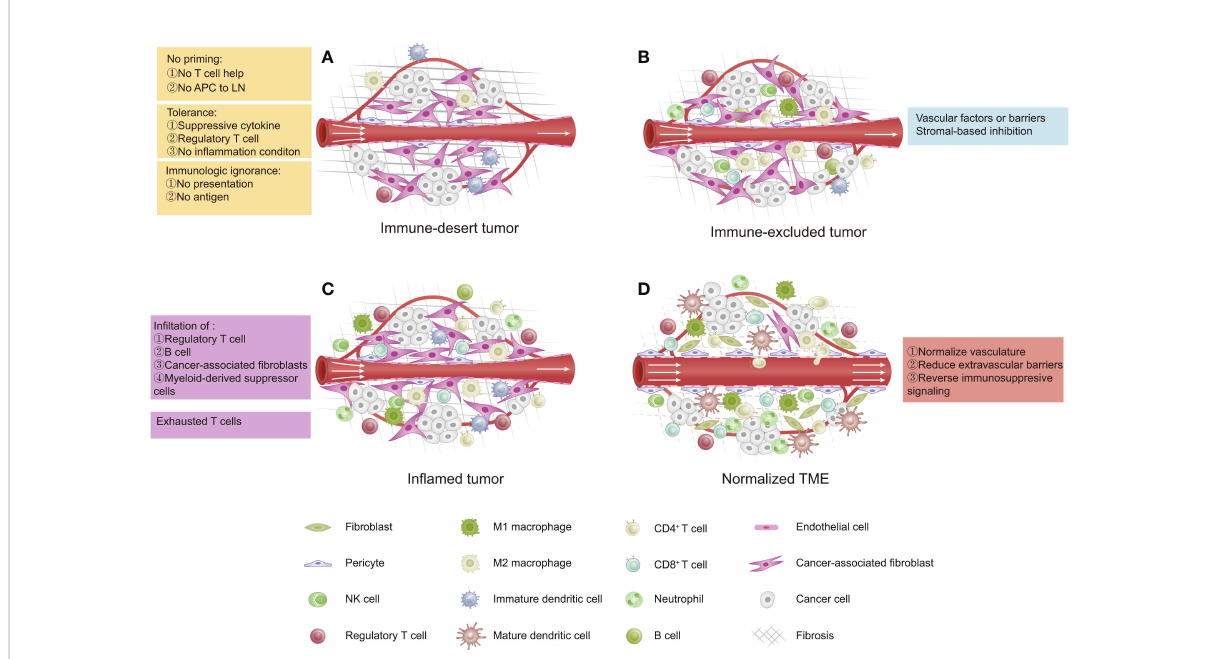
FIGURE 1 Three phenotypes of cancer immunity in the tumor microenvironment (TME). (A) Immune-desert type: characterized by a lack of antitumor immune cells due to low immunogenicity. (B) Immune-excluded type: characterized by immune cells restricted at the tumor periphery due to tumor vascular barriers and stromal-based inhibition. (C) In fl amed type: characterized by immune cells in fi ltrating the tumor parenchyma and expressing pro-in fl ammatory cytokines, but a failed antitumor immune response. (D) Normalized TME by reversing immunosuppressive signaling, improving tumor perfusion, and reducing